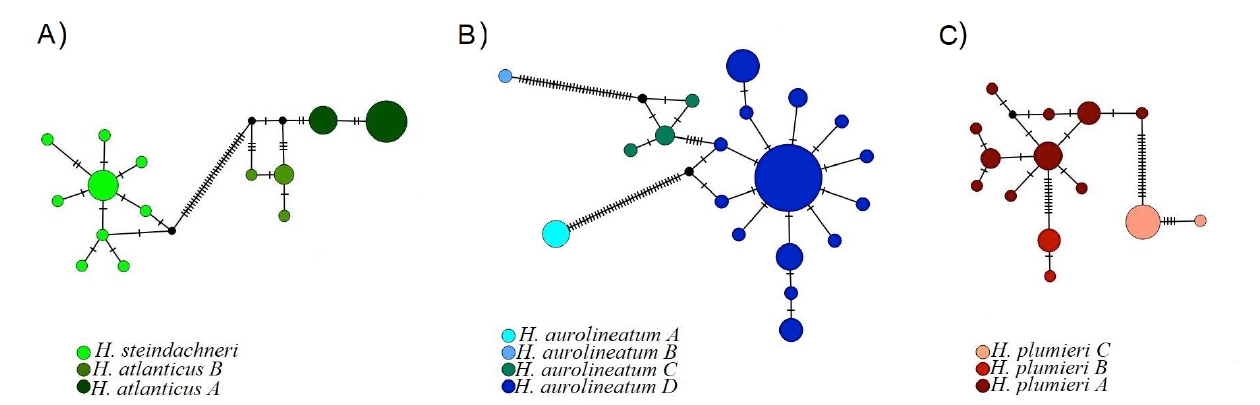
FIGURE 3 | Haplotype networks of the three Haemulon species in which multiple MOTUs were identified. The dashes represent mutational steps. The size of the circle representing each haplotype is proportional to the number of individuals with that haplotype. The black dots represent missing haplotypes. A. H . steindachneri = Haemulon steindachneri (eastern Pacific); H . atlanticus B = specimens from Colombia, Guatemala, and Venezuela; H . atlanticus A = specimens from Brazil and Colombia; B . H . aurolineatum A = specimens from Bermuda; H . aurolineatum B = specimens from Bermuda; H . aurolineatum C = specimens from the United States; H . aurolineatum D = specimens from Belize, Brazil, Colombia, Jamaica, Venezuela, and the United States; and C. H . plumieri C = specimens from Brazil and Puerto Rico; H . plumieri B = specimens from the United States; H . plumieri A = specimens from the Bahamas, Belize, Haiti, Mexico, Puerto Rico, and the United